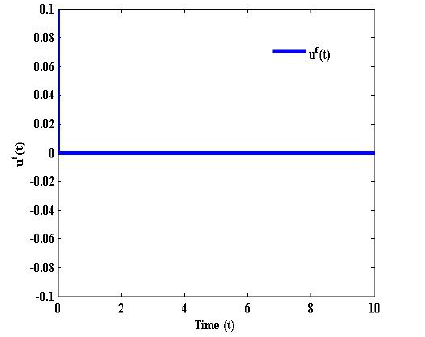
Figure 8. Simulation results of control